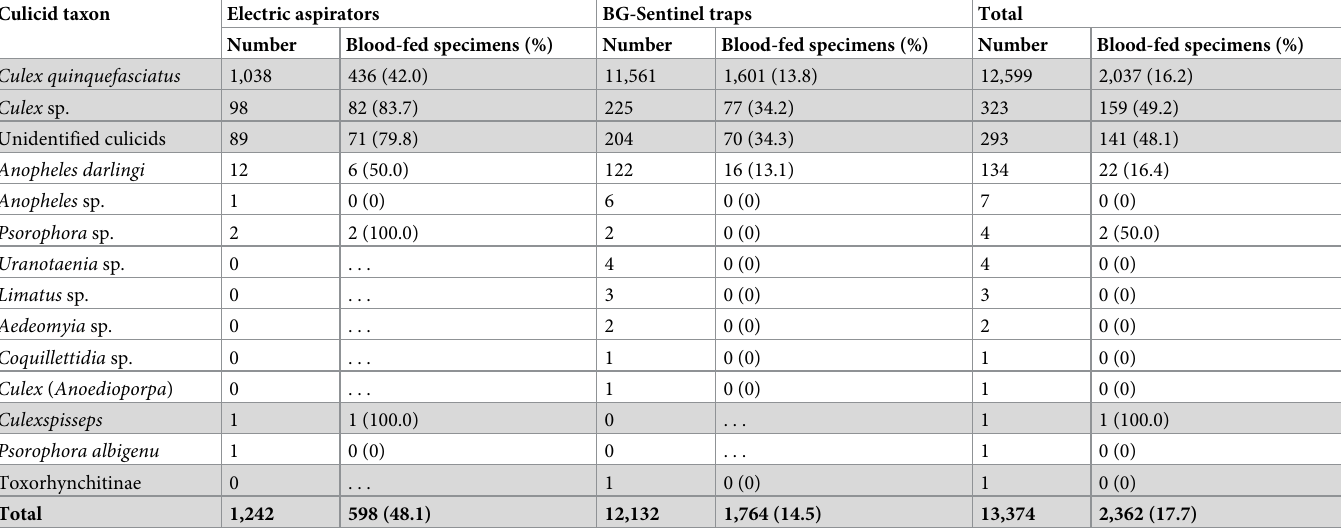
Table 2. Frequency of culicids collected according to trapping method.